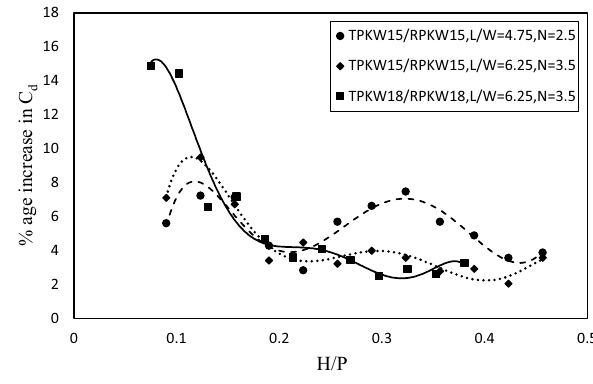
Fig. 7 Increment in discharge coefficient with trapezoidal PK weirs relative to rectangular PK